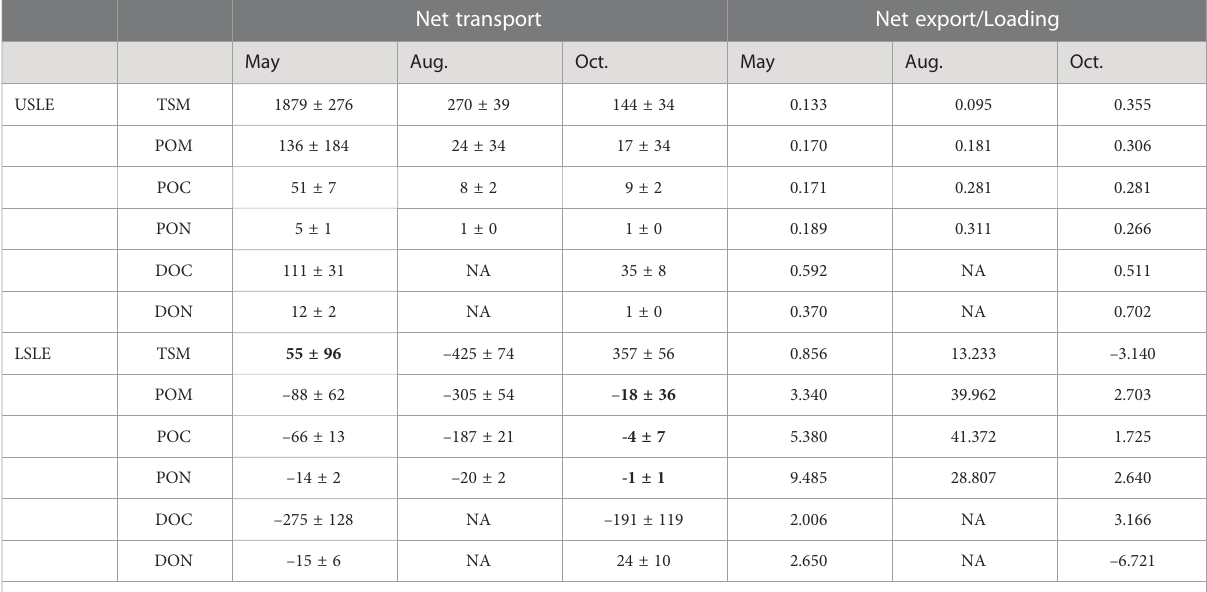
TABLE 4 Net transport (Gg) and net export/loading ratio of TSM and organic matter in the St. Lawrence estuary. Net